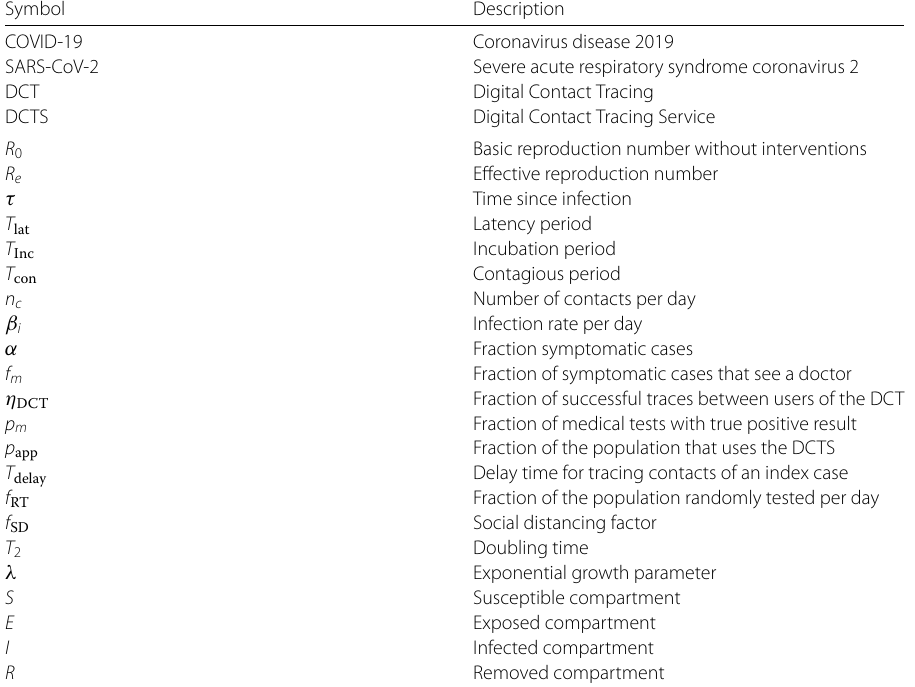
Table 2 List of abbreviations